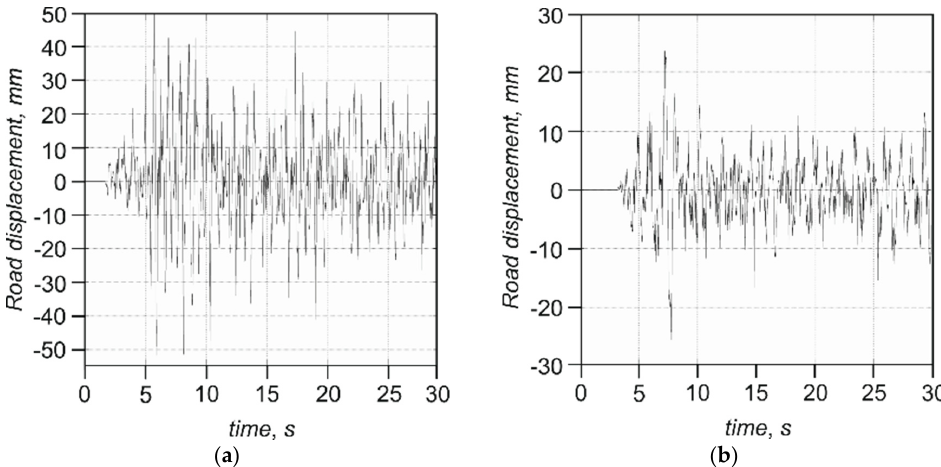
Figure 4. Road displacement dependencies on time, observed experimentally: ( a ) road no. 6; ( b ) road no. 3.